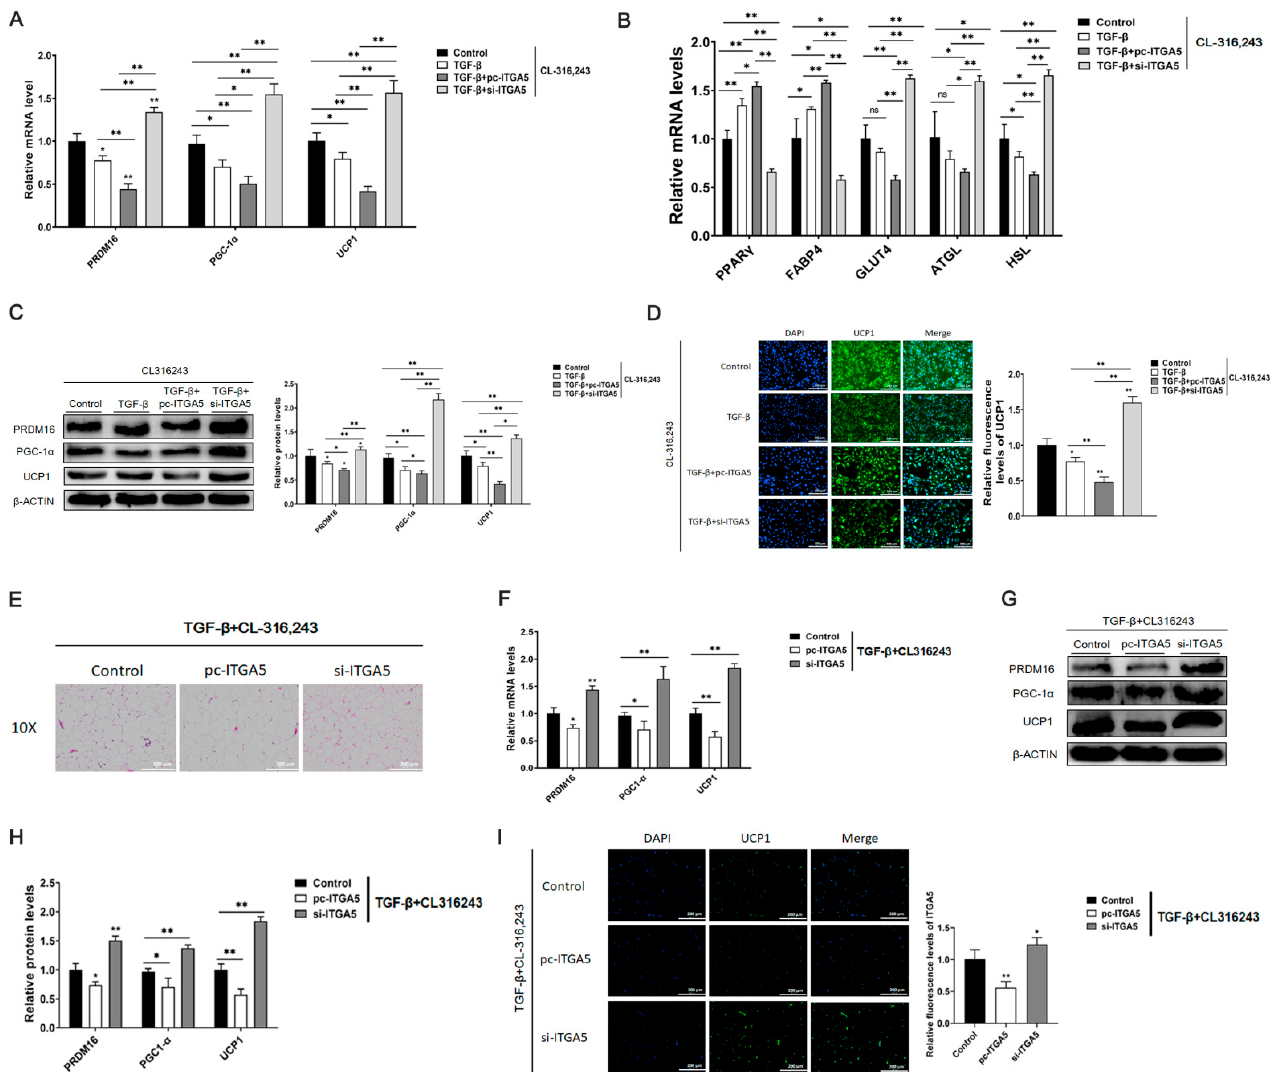
Figure 6. Down regulation of ITGA5 alleviates the inhibitory effect of browning caused by fibrosis. At the cellular level, a cell fibrosis model was constructed by TGF- β treatment, treated with CL316, 243, and then respectively treated with ITGA5 overexpression vector and interference fragment. ( A , B ) The relative mRNA expression levels of adipocyte browning-related genes PRDM16, PGC-1 α , UCP1, PPAR γ , FABP4, GLUT4, ATGL, and HSL ( n = 4). ( C ) The relative protein expression levels of adipocyte browning-related genes PRDM16, PGC-1 α , and UCP1 ( n = 4). ( D ) Immunofluorescence staining of UCP1, scale bar: 200 µ m ( n = 4). At the in vivo level, the adipose tissue fibrosis model was constructed through HFD induced fat rats. Then the ITGA5 overexpression vector and interference fragment were injected subcutaneously for 7 days, and exposed at 4 ◦ C for 24 h. We extracted the subcutaneous adipose tissue of the mouse groin. ( E ) HE staining of adipose tissue sections, scale bar: 100 µ m ( n = 4); ( F – H ) Relative mRNA and protein expression levels of adipocyte browning-related genes PRDM16, PGC-1 α , and UCP1 ( n = 4). ( G ) UCP1 immunofluorescence of adipose tissue sections, scale bar: 200 µ m ( n = 4). ( I ) Values are means ± SD, * p < 0.05, ** p < 0.01 compared with the control